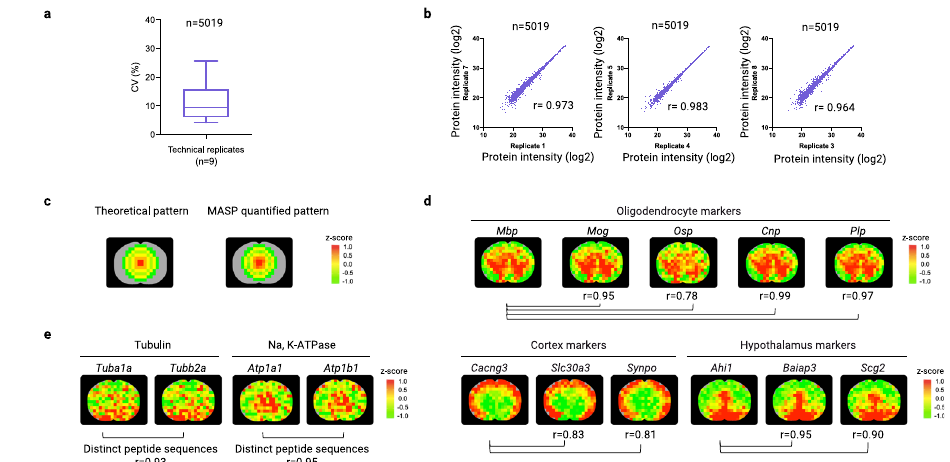
Fig. 3 | The high reproducibility and accuracy of the MASP pipeline. a Intra- group CV% of the quantitative values of 5019 quanti fi ed proteins among sample preparation replicates of a pooled quality control (QC) sample (analyzed once every 20 micro-specimens, N =9).The boxshows the 25th to 75th percentilerange with the median indicated by a horizontal line. Whiskers extend to the 10th and 90th percentile range. b The correlation of quantitative values of 5019 quanti fi ed proteins between randomly-selected runs of the QC sample. c The agreement between the theoretical distribution and MASP-acquired map of strategically